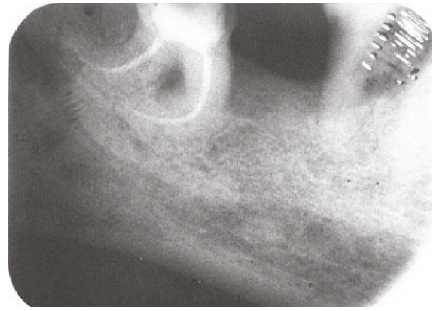
Figure 3: Post obturation radiograph.